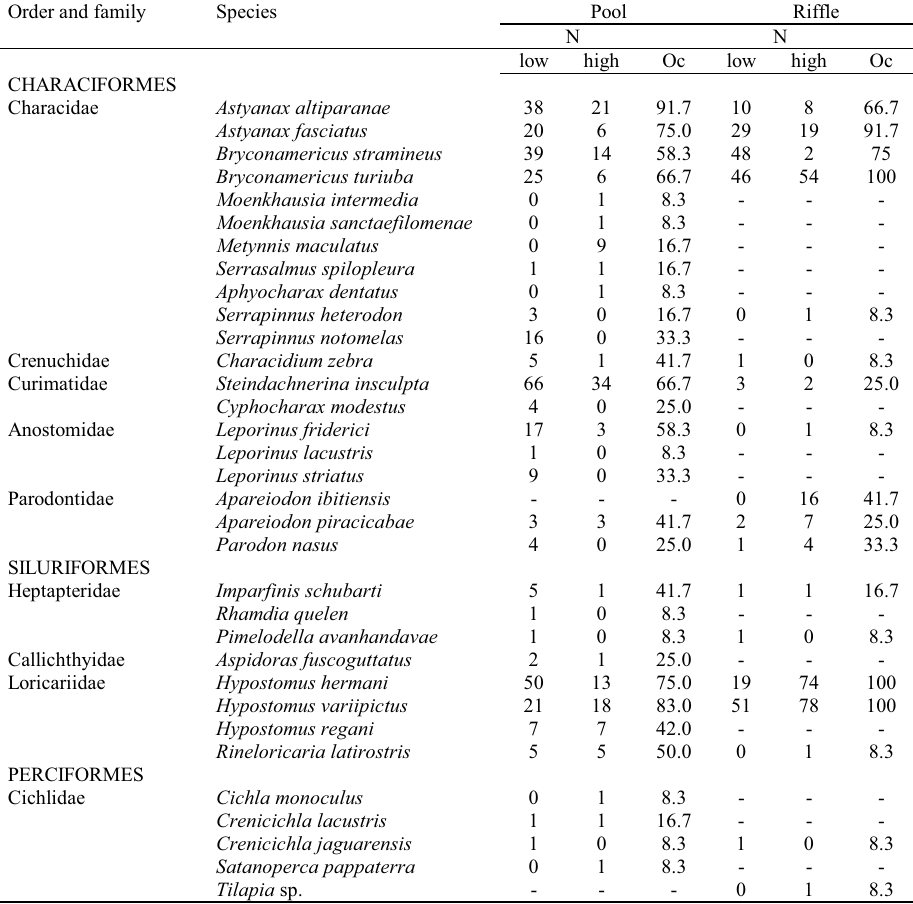
Table 2. Fish Species Collected in the Ribeirão Santa Bárbara Mesohabitats with Total Number of Specimens (N) and Occur- rence (Oc, in Percentage). Low and High Refer Respectively to Low and High